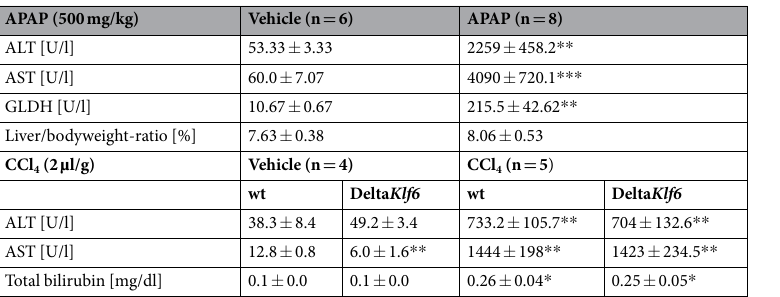
Table 2. Mouse baseline parameters after treatment with APAP (wildtype animals) or acute CCl 4 treatment (wildtype and Delta Klf6 animals). * p < 0.05; ** p < 0.01; *** p < 0.001 versus vehicle